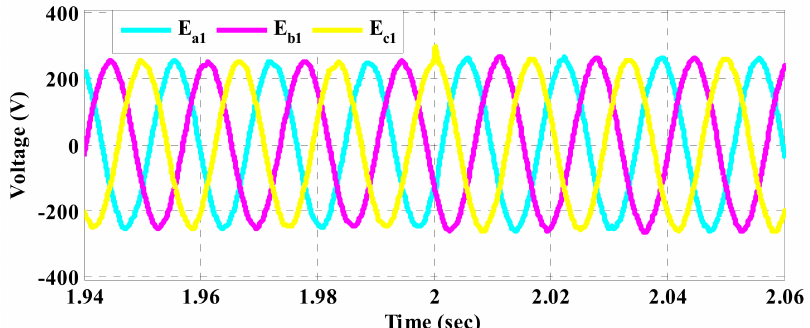
Figure 5. Load-side voltage waveforms of DG1 based on the conventional control method.